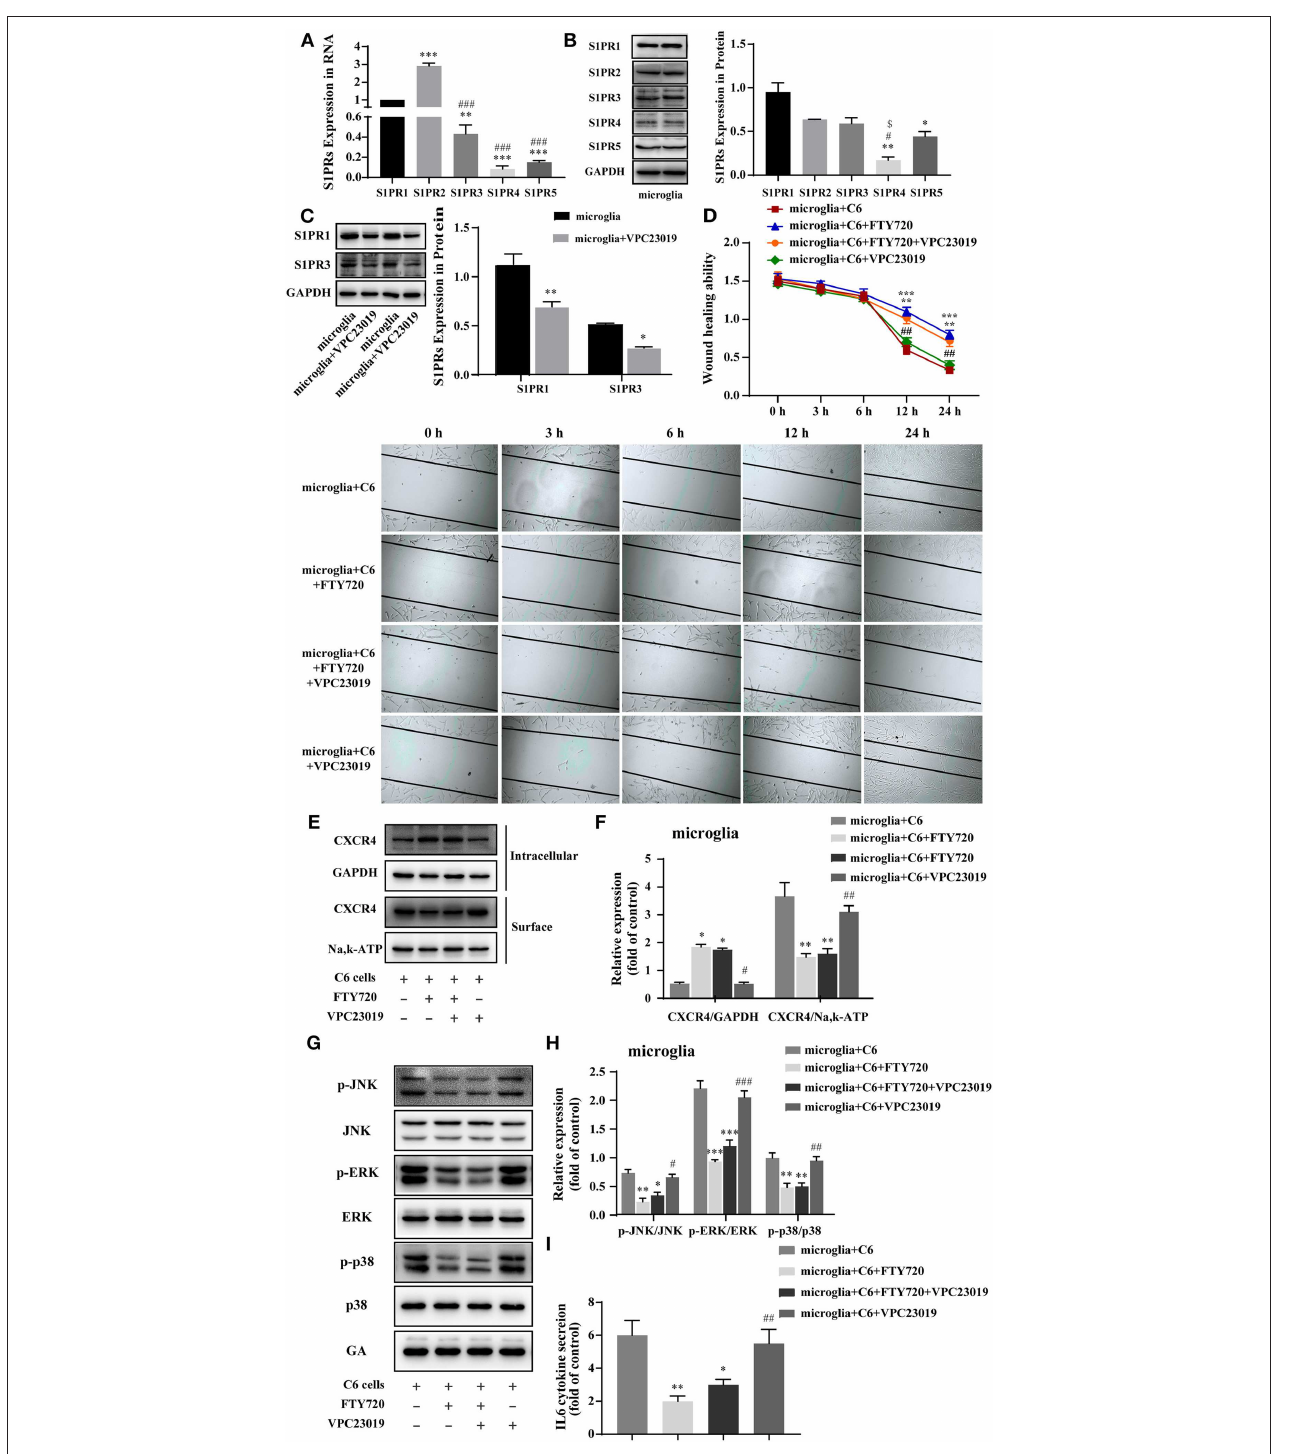
FIGURE 4 | FTY720 exerts anti-glioma effects via CXCR4 instead of S1PRs. (A,B) The representative RNA and protein expression of S1PR1, S1PR2, S1PR3, S1PR4, and S1PR5 in microglia. (C) Western blots analyzed the expression of S1PR1 and S1PR3 in microglia treated with VPC 23019, respectively. (D) Representative images and analysis of C6 cells motility under different treatment. (E,F) The intracellular and cell-surface CXCR4 under different treatment is analyzed by Western blots. (G,H) Western blots analyze the phosphorylation of p38, JNK, and ERK1/2 under different treatments. (I) The concentration of IL-6 in the cell culture supernatants. Data are presented as mean ± SEMs, n = 3 for qPCR assays, ** p < 0.01, *** p < 0.001 vs. S1PR1, ### p < 0.01 vs. S1PR2; n = 3 for Western blots of S1PRs, * p < 0.05, ** p < 0. 01 vs. S1PR1, # p < 0.05 vs. S1PR2, $ p < 0.05 vs. S1PR3; n = 3 for wound healing assays, ** p < 0.01, *** p < 0.001 vs. microglia + C6, ## p < 0.01 vs. microglia + C6 + FTY720; n = 3 for Western blots, * p < 0.05,** p < 0.01, *** p < 0.001 vs. microglia + C6, ## p < 0.01, ### p < 0.01 vs. microglia + C6 + FTY720.